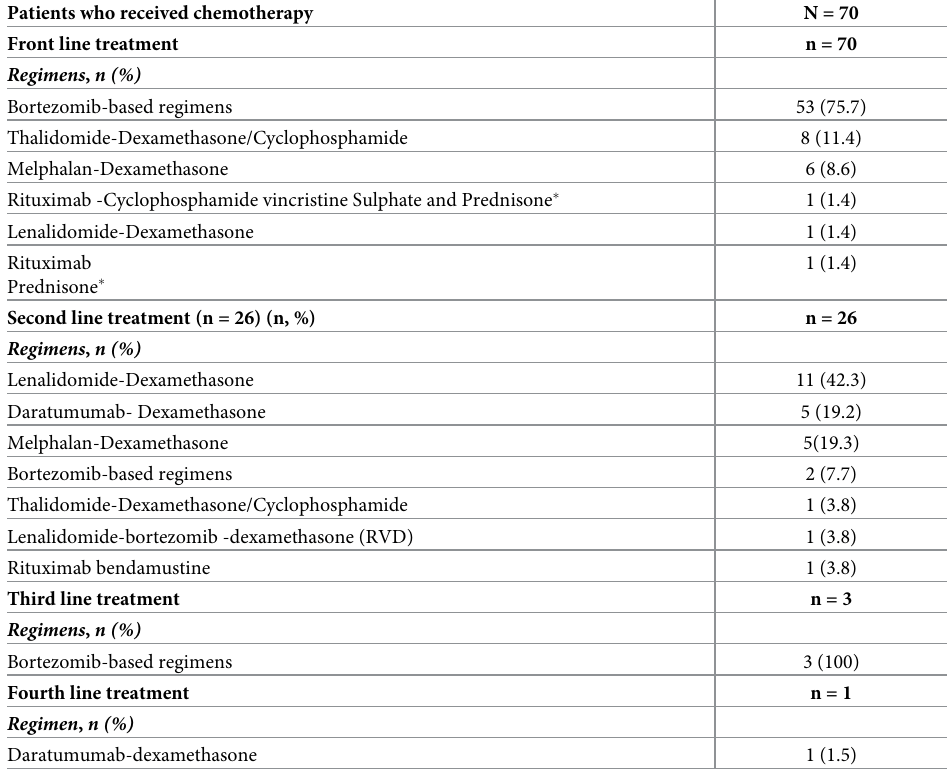
Table 2. Regimens used for AL amyloidosis patients per line of treatment. Patients who received